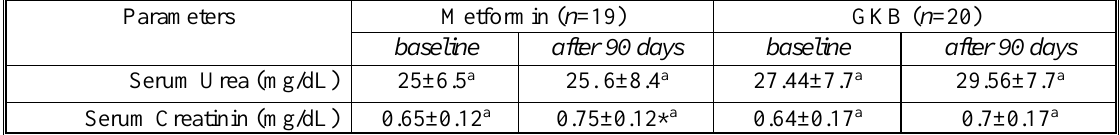
Table 3. Effect of Gingko biloba extract (GKB) on the renal function markers of patients with metabolic syndrome .